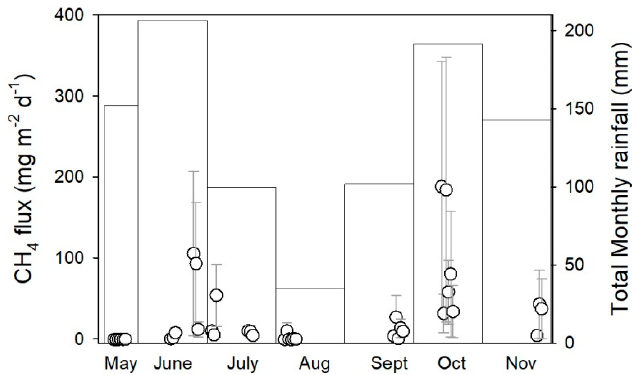
Figure 4. Average daily CH 4 fluxes ( ± 1 SE, n = 8) measured in the downhill area of Ankasa Reserve from May to November 2010. The bars (reference y-axis on the right) represent the total monthly rainfall (mm) from the TRMM database (Tropical Rainfall Measuring Mission, NASA).